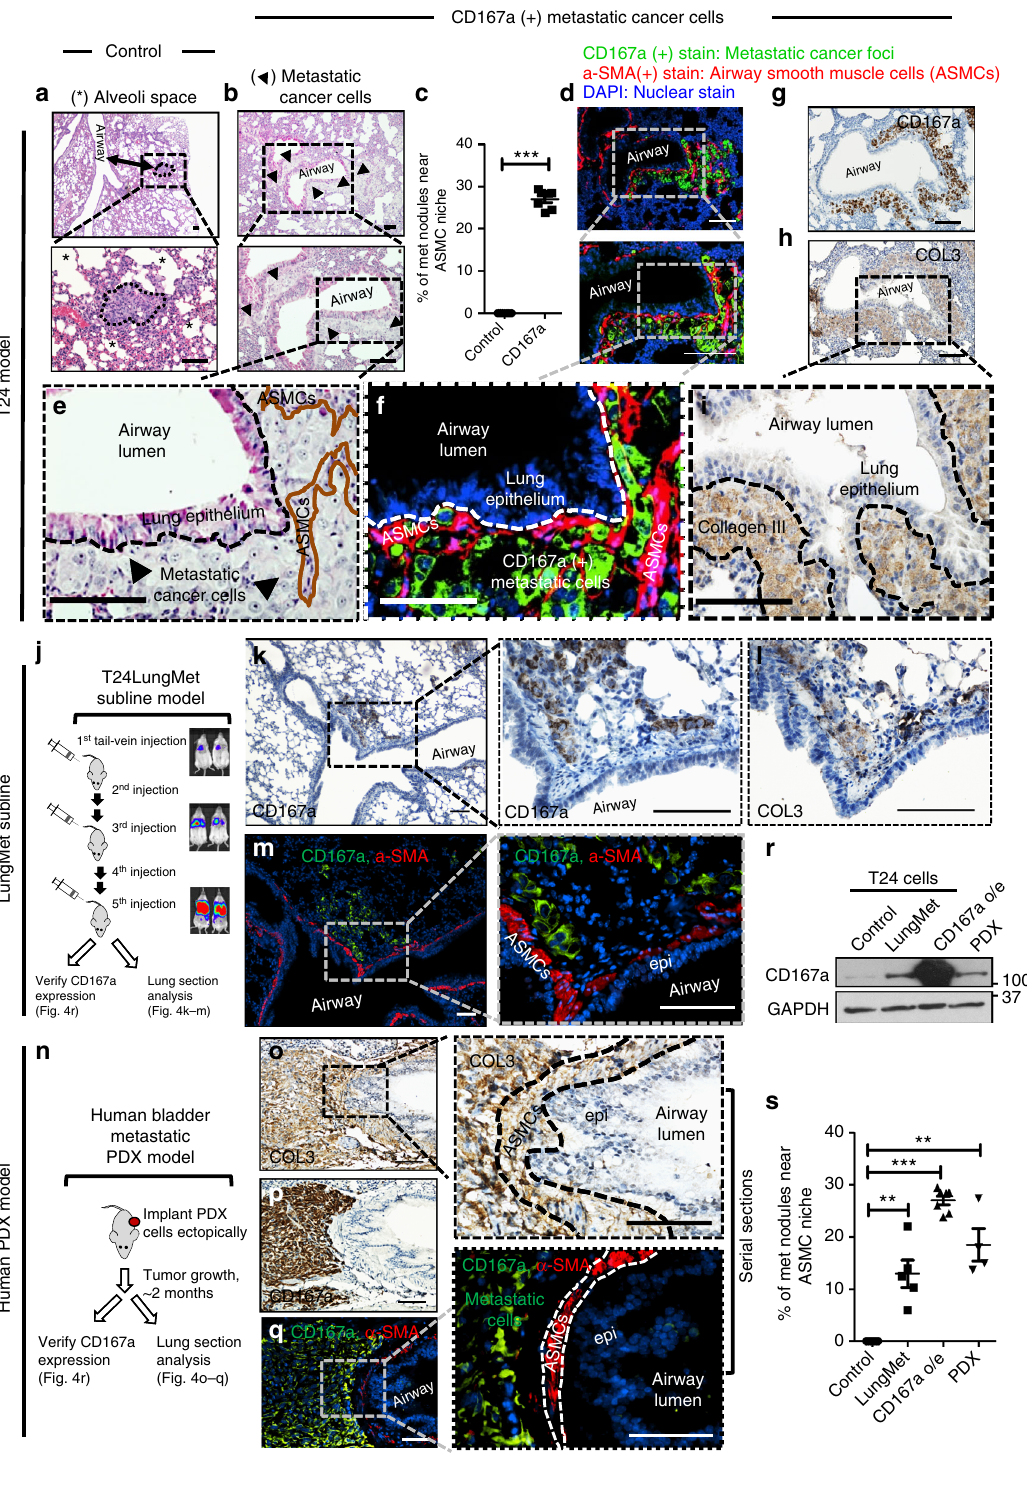
4 th injection 5 th